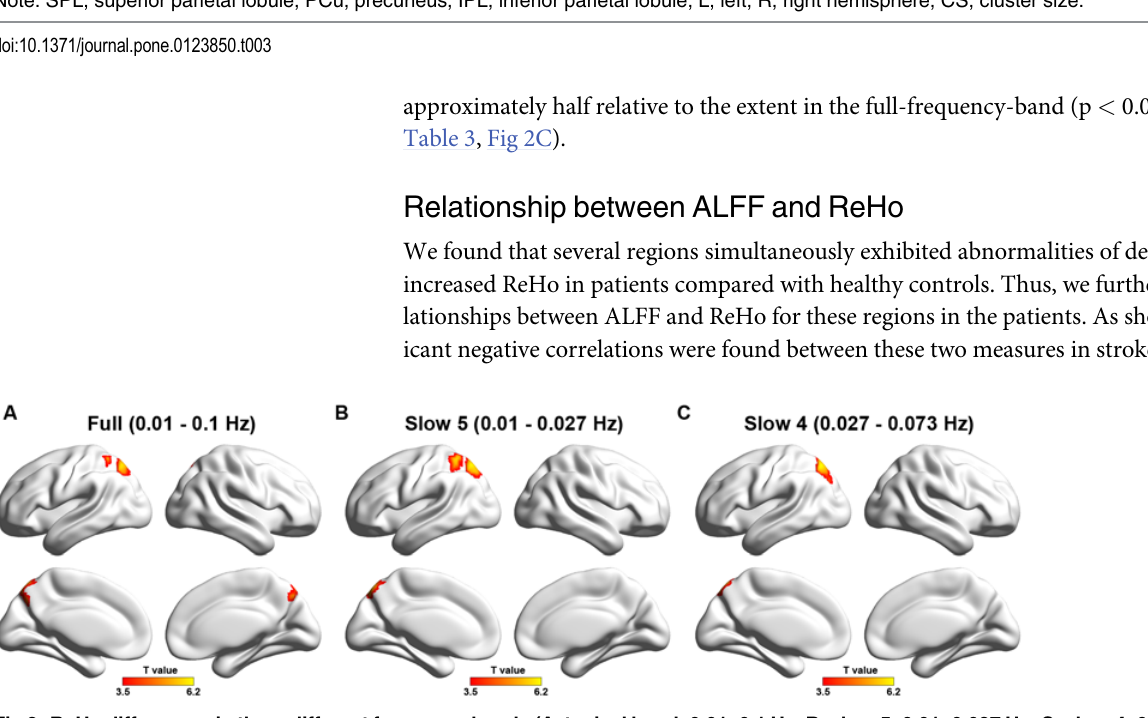
Fig 2. ReHo differences in three different frequency bands (A, typical band: 0.01 – 0.1 Hz; B, slow-5: 0.01 – 0.027 Hz; C, slow-4: 0.027 – 0.73 Hz) between stroke patients and healthy controls. Warm colors indicate regions showing higher ReHo in patients versus controls. Threshold for ReHo: p < 0.05 (corrected). Left in the figure shows the left side of the brain.